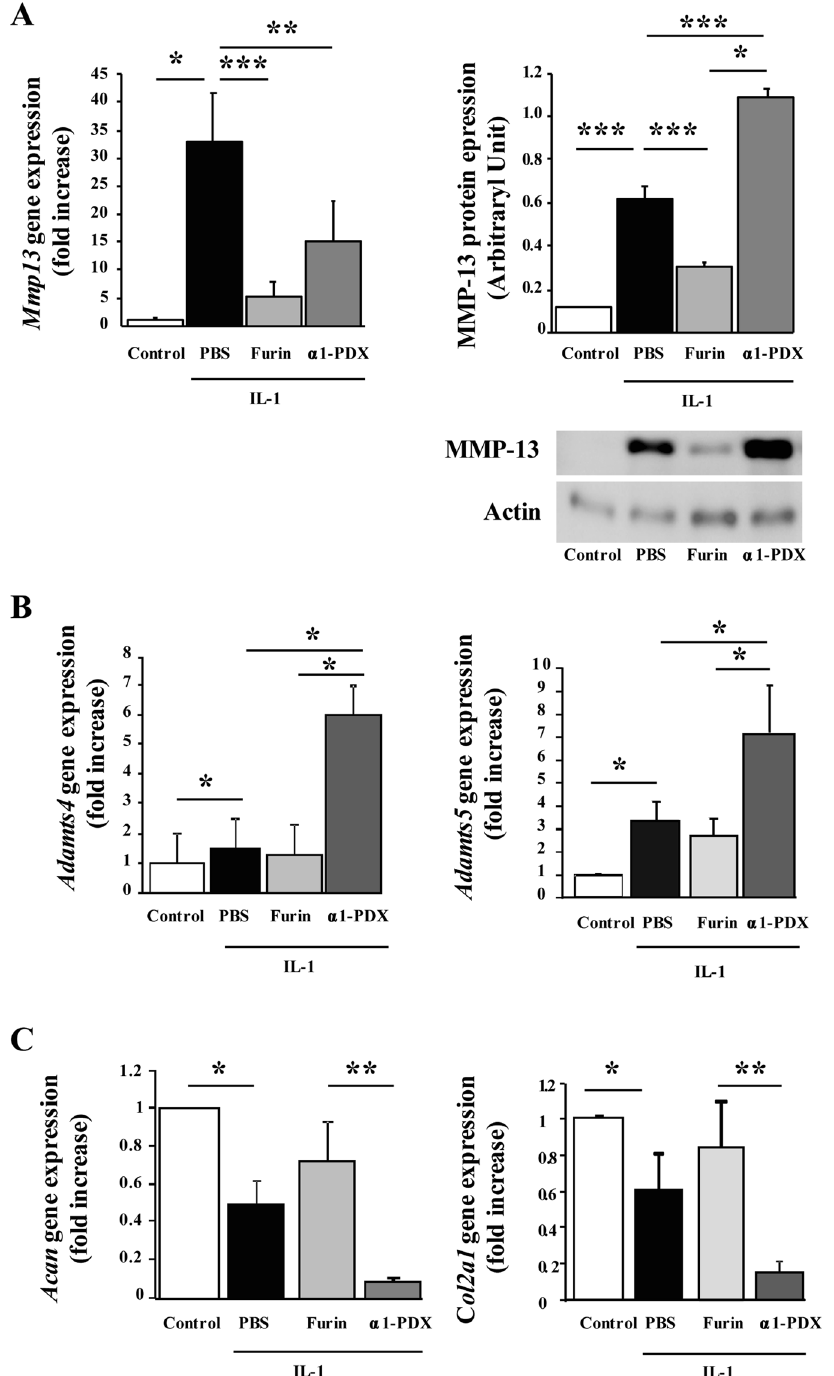
Figure 1. Furin regulates MMP-13 activation in IL-1-stimulated chondrocytes. Primary mouse chondrocytes were stimulated with IL-1 and then cultured with PBS, Furin, α 1-PDX. ( A ) Quantitative RT-PCR and western blot analysis of mRNA and protein expression of MMP-13, in controls or interleukin-1 (IL-1)-stimulated primary chondrocytes with PBS, Furin (10 U/mL) and α 1-PDX (8 µ M) treatment. Data for RT-PCR are fold increase relative to control and signal intensity relative to Actin for western blot. ( B ) Quantititative RT-PCR analysis of mRNA levels of ADAMTS-4 and ADAMTS-5 expressed as fold increase. ( C ) Quantititative RT-PCR analysis of mRNA levels for aggrecan ( Acan ) and type II collagen ( Col2a1 ). Data are mean ± SEM. * p < 0.05, ** p < 0.01, *** p <